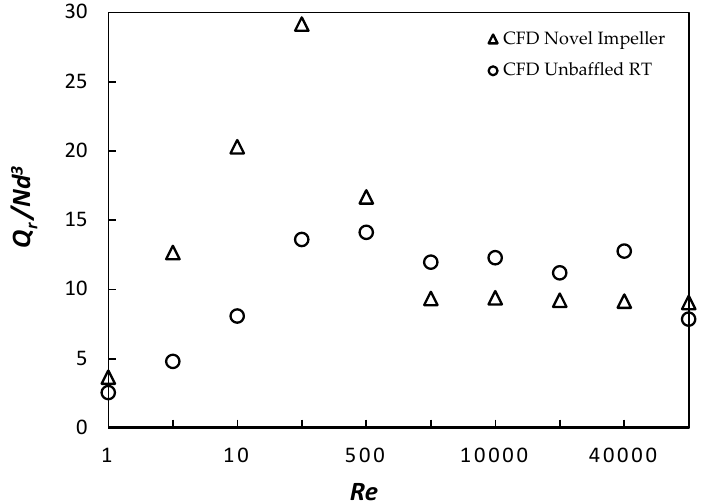
Figure 5. Normalized radial pumping capacity in the function of the Reynolds number.